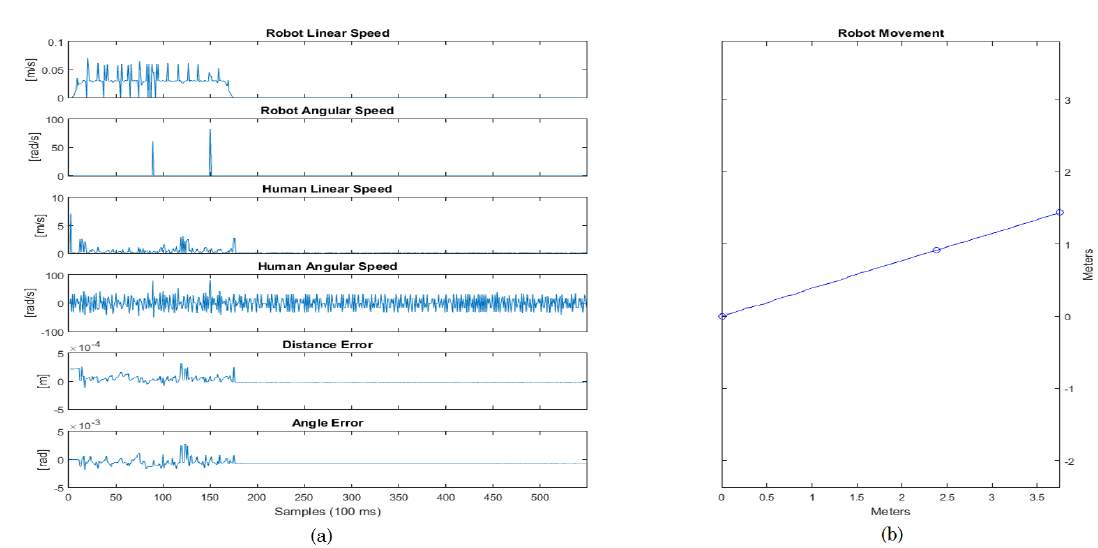
Figure 19. Results for the straight path. ( a ) Graphical data about the experiment; ( b ) Graphical path of the experiment.